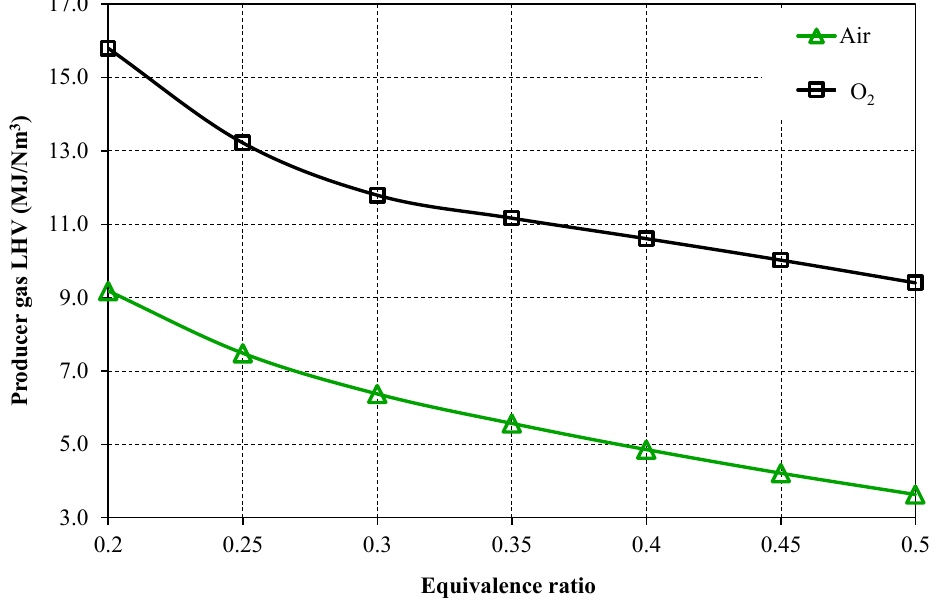
Figure 6. Producer gas LHV.